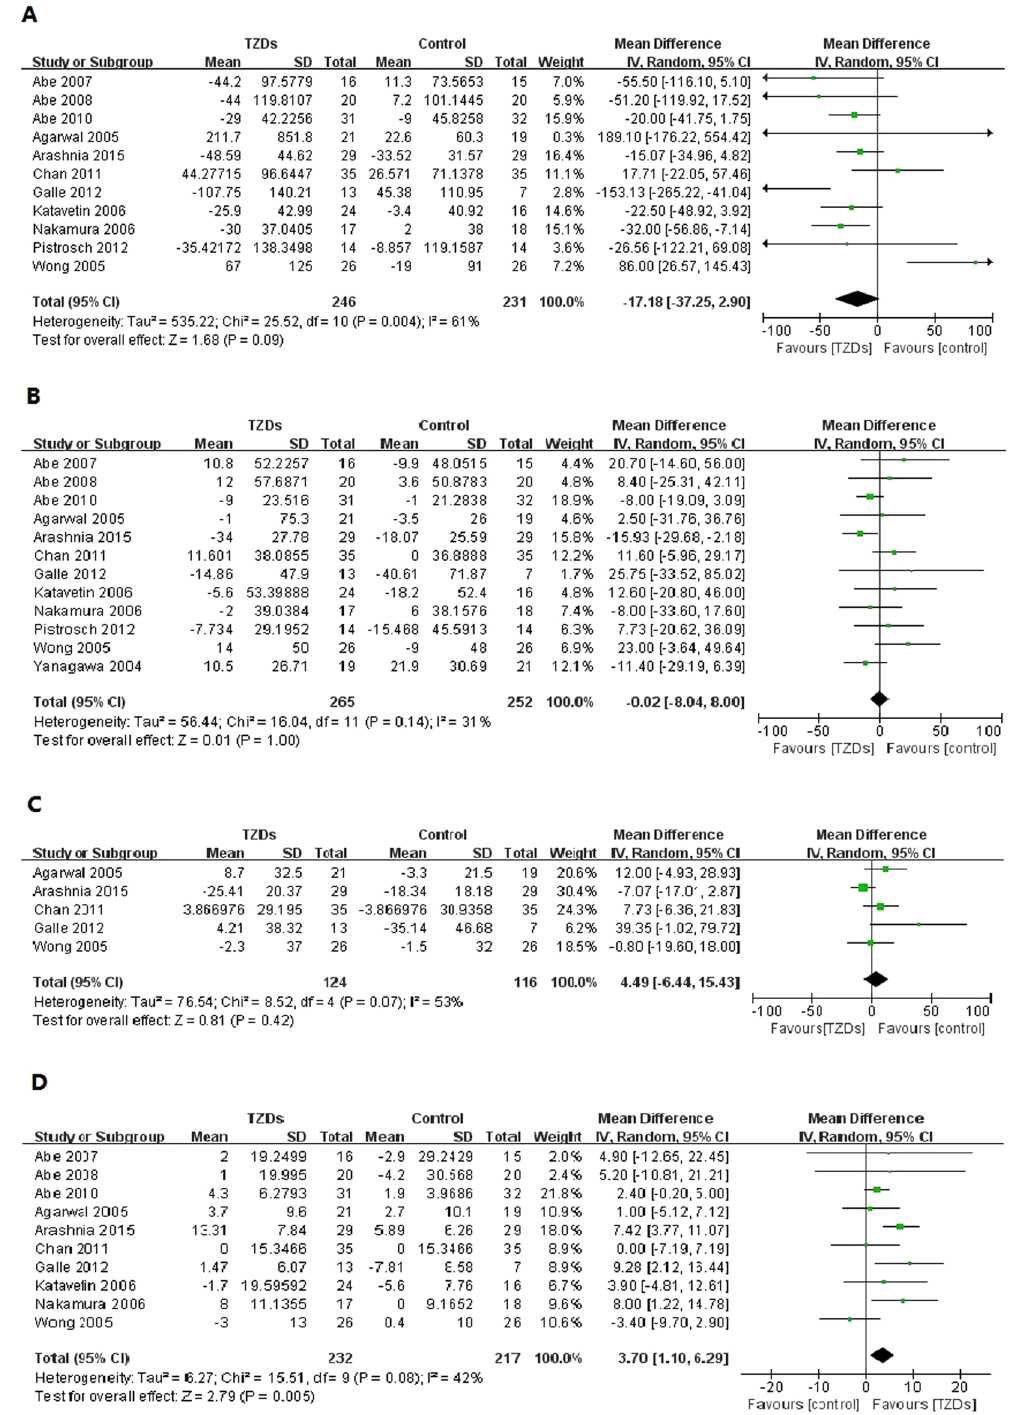
Figure 4. Changes in serum lipids and lipoproteins among patients with diabetes mellitus and renal impairment receiving TZDs versus control from RCTs. ( A ) Change in triacylglycerol (TG), ( B ) Change in total cholesterol (TC), ( C ) Change in low-density lipoprotein (LDL), ( D ) Change in high-density lipoprotein